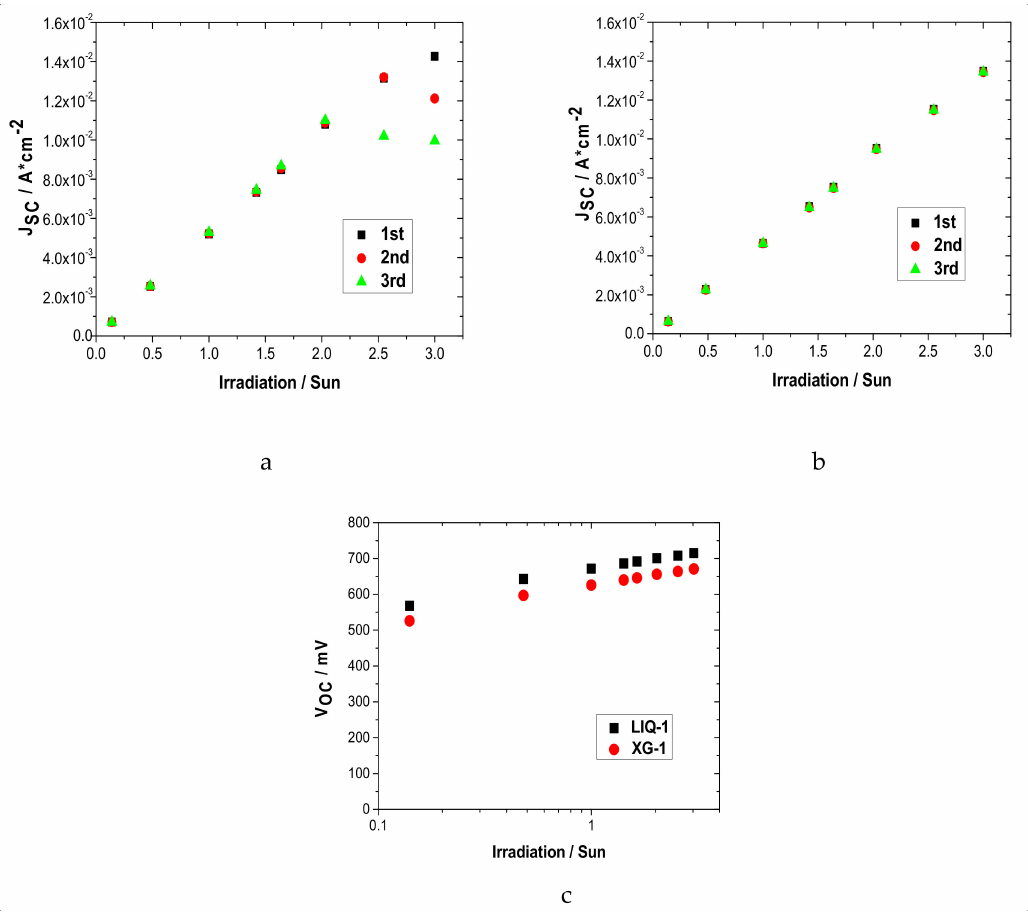
Figure 4. Photocurrent ( a ) LIQ-1 and ( b ) XG-1 based DSSCs, and ( c ) photovoltage in function of the light intensity for the best DSSCs, performed after ≈ 800 h of aging